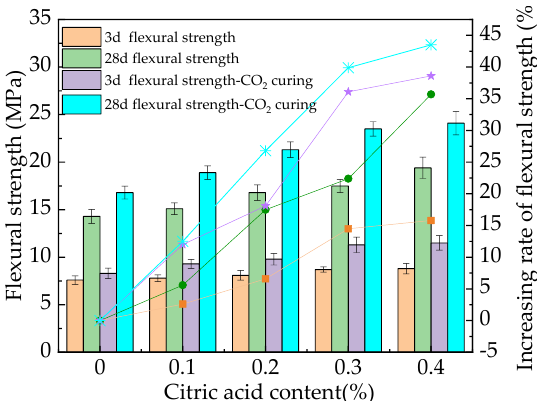
Figure 4. The flexural strength of the MOS paste.